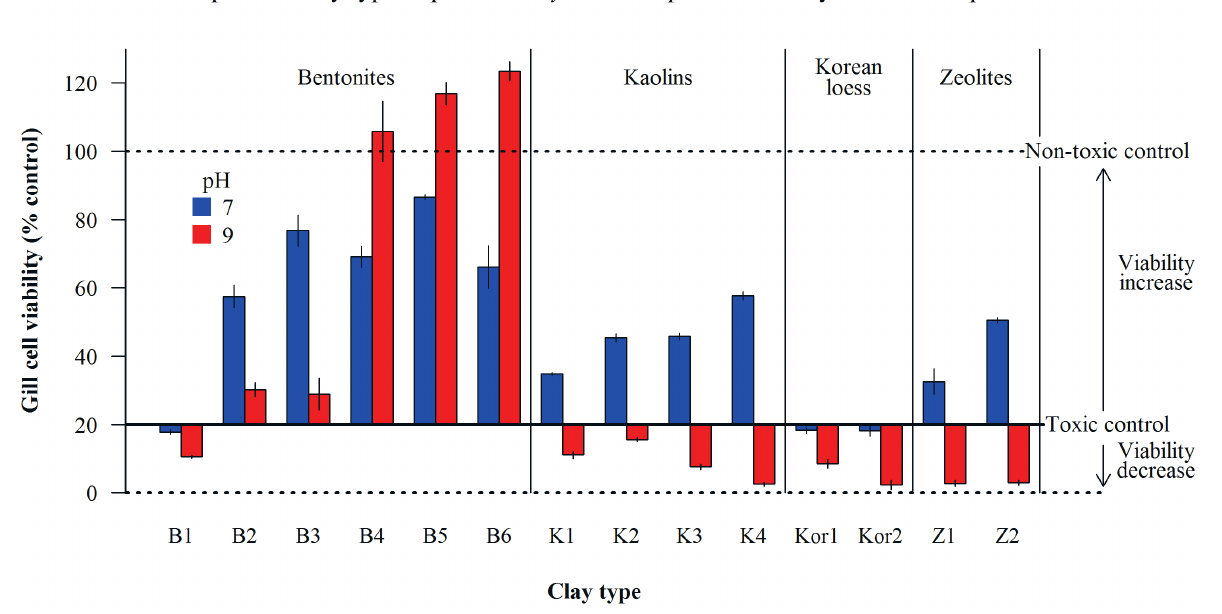
Figure 5. Gill cell viability after exposure to ichthyotoxic P. parvum preparations treated with different clay types at pH 7 (blue bars) and 9 (red bars). Arrows indicate the direction of fish gill viability change compared to the toxic control (solid black line, 20%